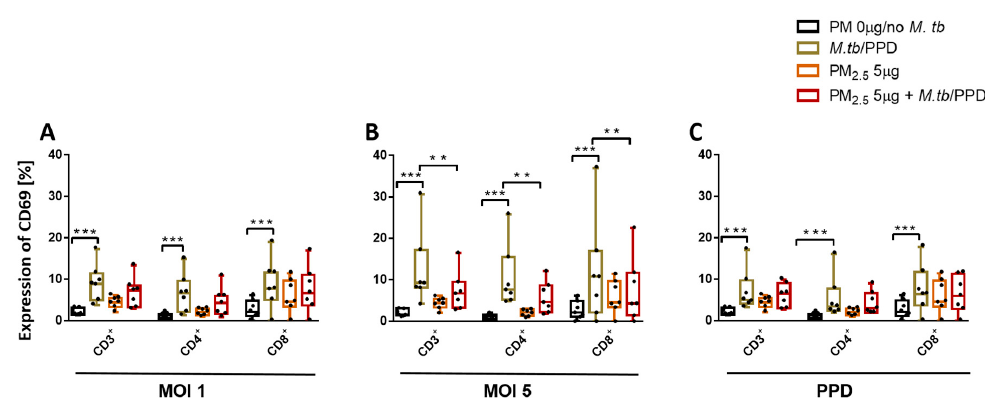
Figure 4. PM 2.5 exposure downregulates the surface expression of the early T cell activation marker CD69. ( A , B ) PBMC from seven study subjects were pre-exposed to PM 2.5 (5 µ g / mL) for 20 h followed by infection with M.tb MOI 1 and 5 for 18 h. Flow cytometric analysis of CD69 expression, PBMC were surface stained with anti-CD3, -CD4, -CD8, -CD69 monoclonal antibodies and viability dye eFluor780. Percent expression of CD69 in seven independent experiments on CD3 + , CD4 + , and CD8 + cells is shown with 5 / 95 percentile box-and-whiskers where the center represents the 50th percentile, the upper hinge the 75 th percentile, and the lower hinge the 25 th percentile. Statistically significant increases between expression levels of M.tb-uninfected and M.tb-infected PBMC are shown with triple ( p < 0.001) asterisks while statistically significant decreases between results for M.tb-infected and PM 2.5 -exposed/M.tb-infected PBMC are shown with double ( p < 0.01) asterisks.